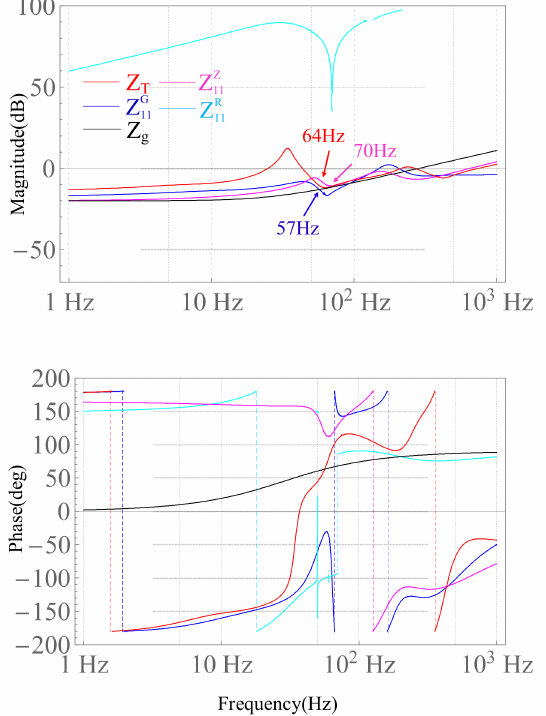
Figure 11. Entire impedance with/without the frequency coupling under L g = 0.56 mH (SCR = 2) ( Z Z is the entire impedance of positive sequence without coupling. Z G 11 of positive sequence perturbation without coupling. Z R sequence. Z g is the grid impedance. Z T is the entire impedance of DFIG-based system considering coupling